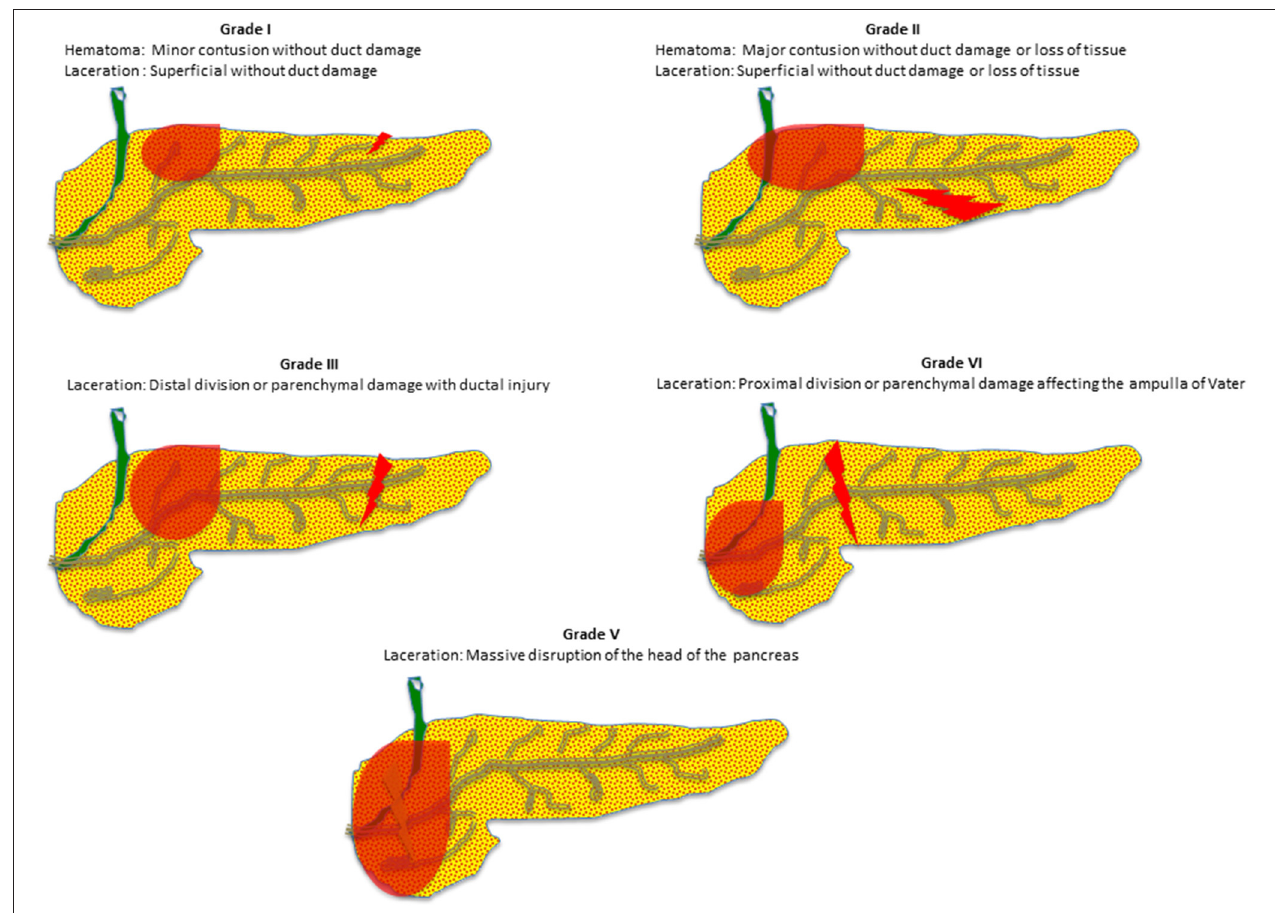
FIGURE 1 | Illustration of pancreatic injury grades (I–V)